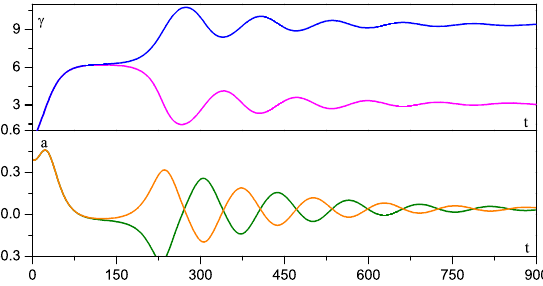
Figure 6. Attraction of amplitude and phase to different constant values.